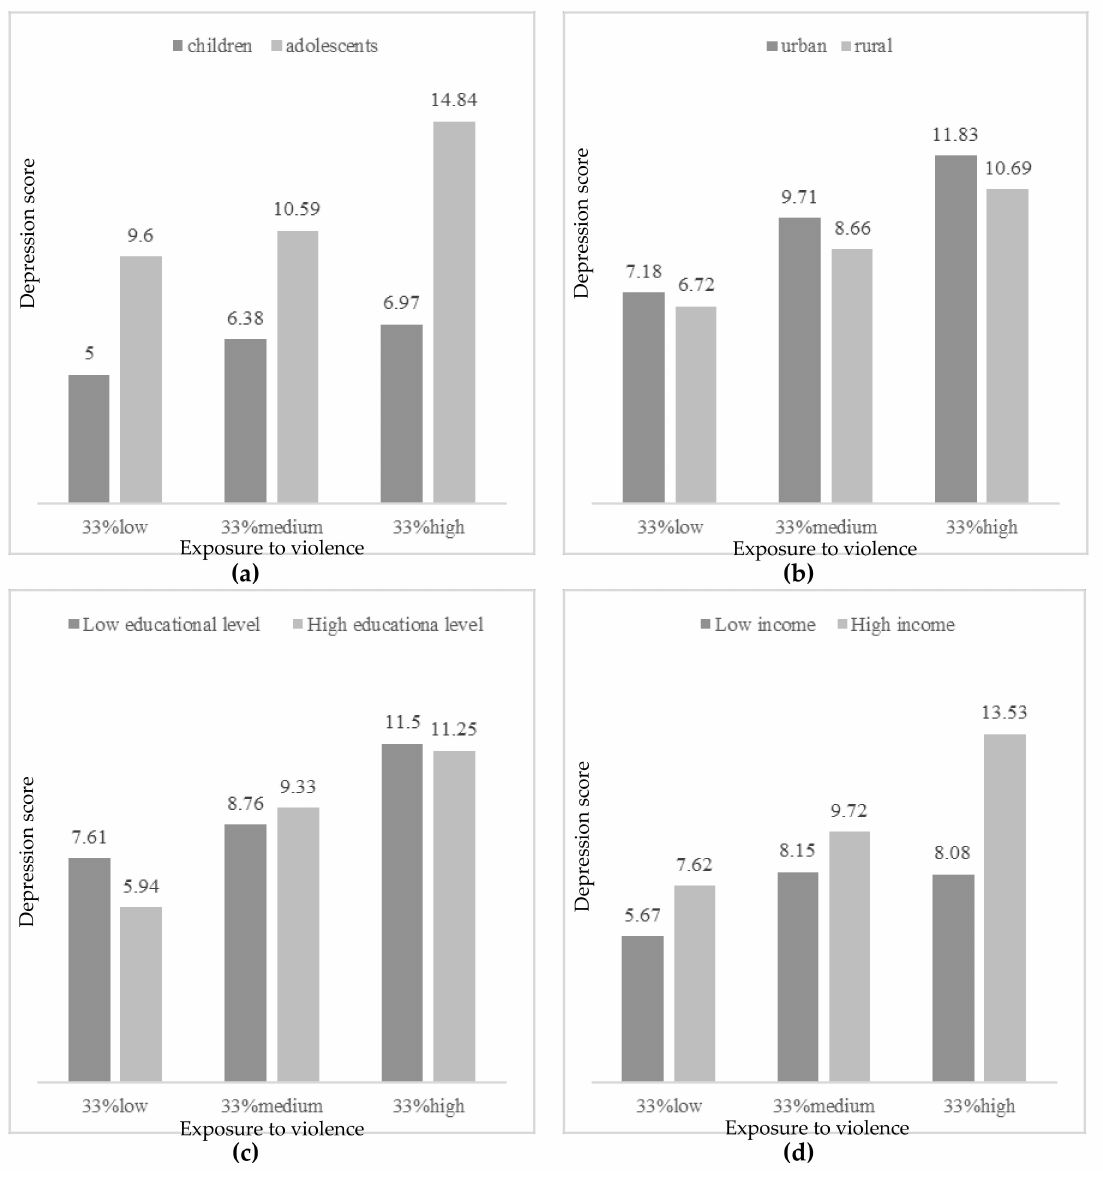
Figure 1. Depressive symptoms by exposure to violence (33% low, 33% medium, 33% high) according to ( a ) age (children vs. adolescents); ( b ) habitat (urban vs. rural); ( c ) educational level (low vs. high); and ( d ) income per capita (low vs.